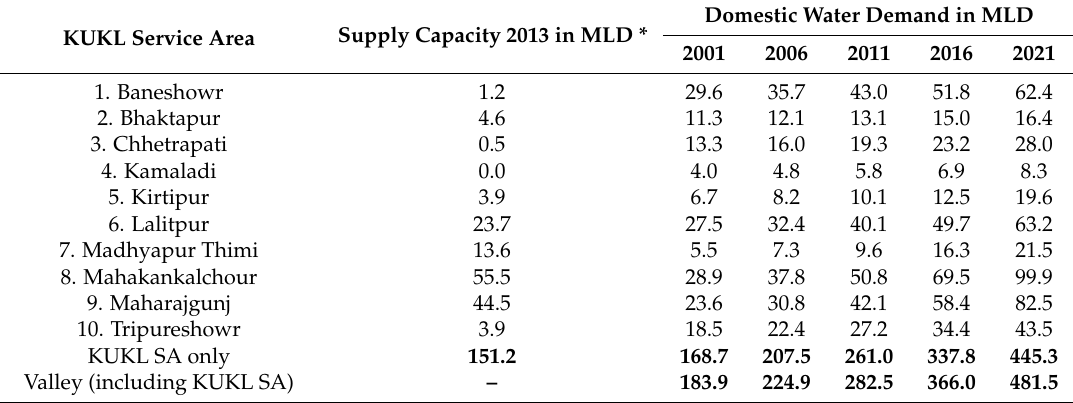
Table 2. Kathmandu Upatyaka Khanepani (KUKL) Service Area estimated water demand using BIS